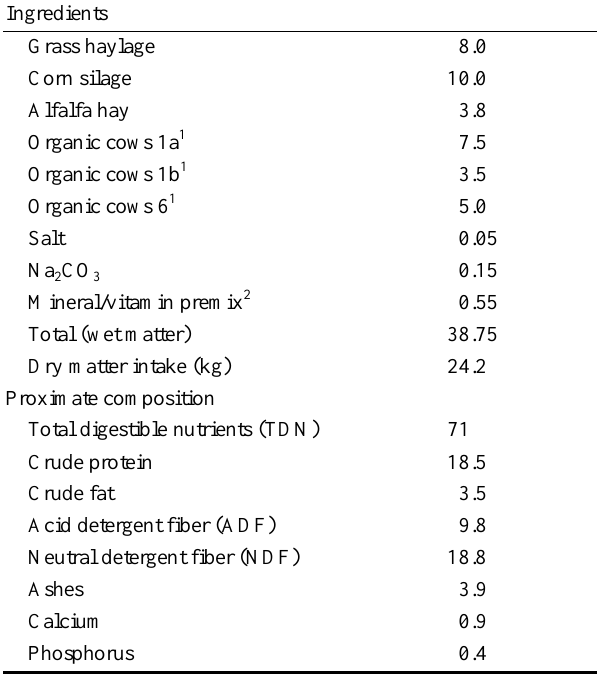
Table 2. Ingredients (kg, wet matter) and proximate (% dry matter) composition of the TMR fed to dairy cows (Experiment 1) Ingredients